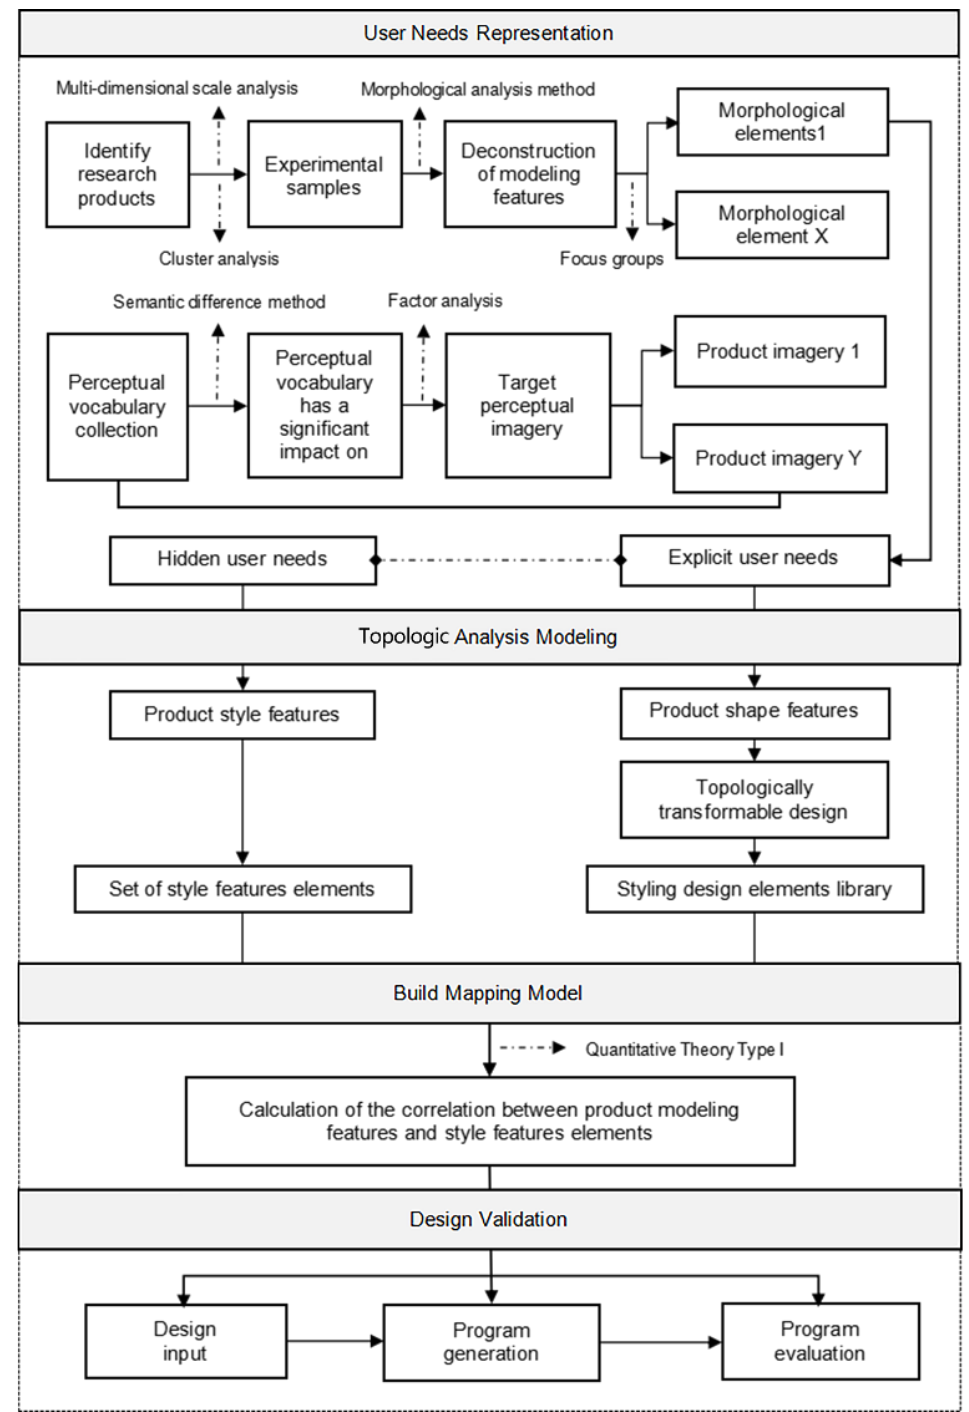
Figure 1. Flow chart of product modeling design based on topology